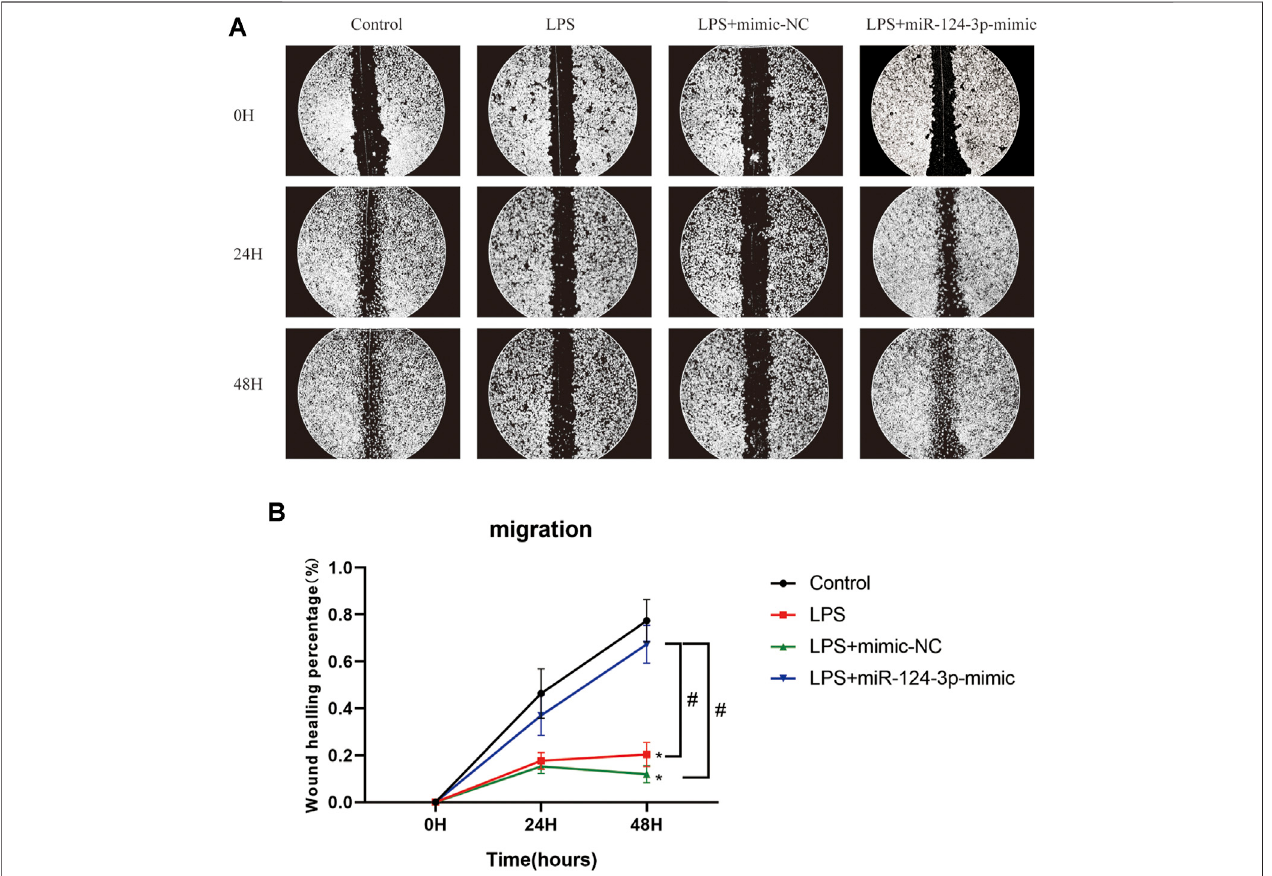
FIGURE 6 | miR-124-3p promoted migration in LPS-induced BV2 microglia. (A,B) A scratch (wound healing) assay was used to determine the effect of hsa-miR- 124-3p onthemigrationofLPS-induced BV2microglia. Theimagesofgapsweretakenat0,24,and48 haftertreatment.Thewoundhealingratewasusedtocalculate the migration ability of each group; n (cid:2) 3. All values were represented as mean ± SD. Difference to control: * p < 0.05; # Difference between groups: # p < 0.05; one-way ANOVA with the Newman – Keuls multiple comparison test.